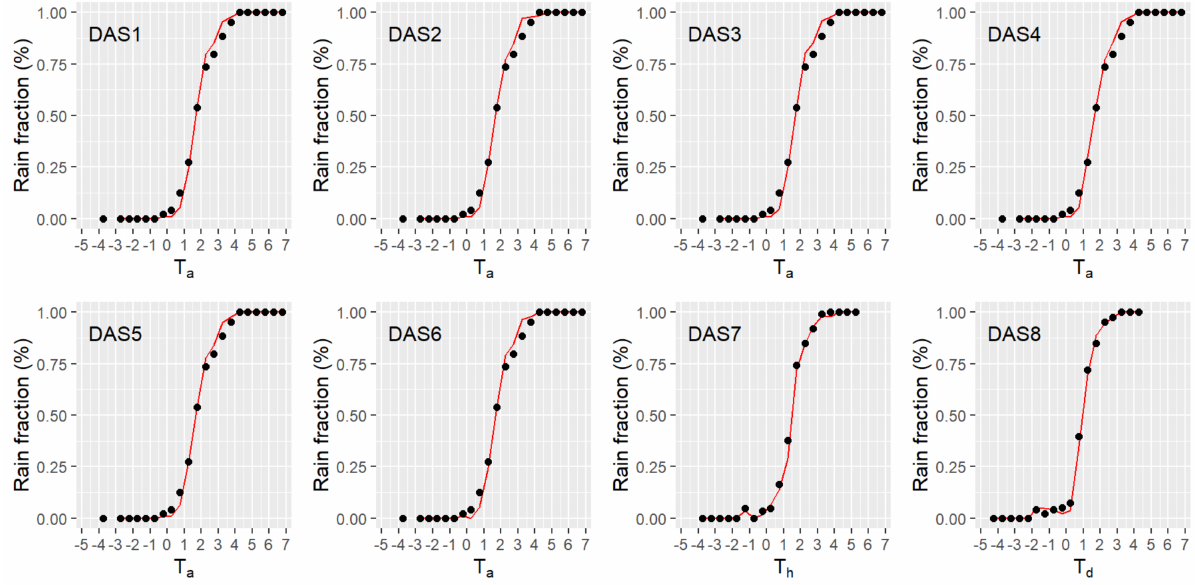
Figure 8. Precipitation phase plots using RF for DAS1 to DAS8 from left to right and from top to bottom. The black dots represent the observed values, and the red lines represent the simulated